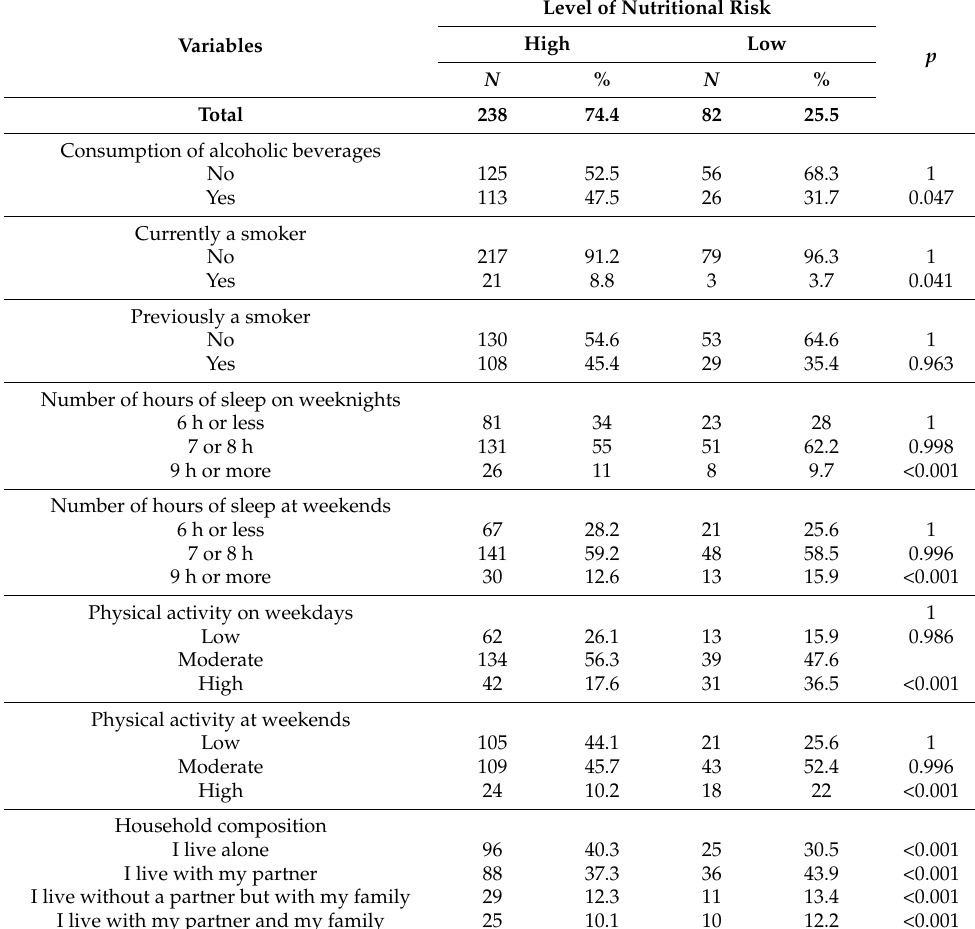
Table 4. Incidence of nutritional risk in relation to selected lifestyle characteristics. Level of Nutritional Variables